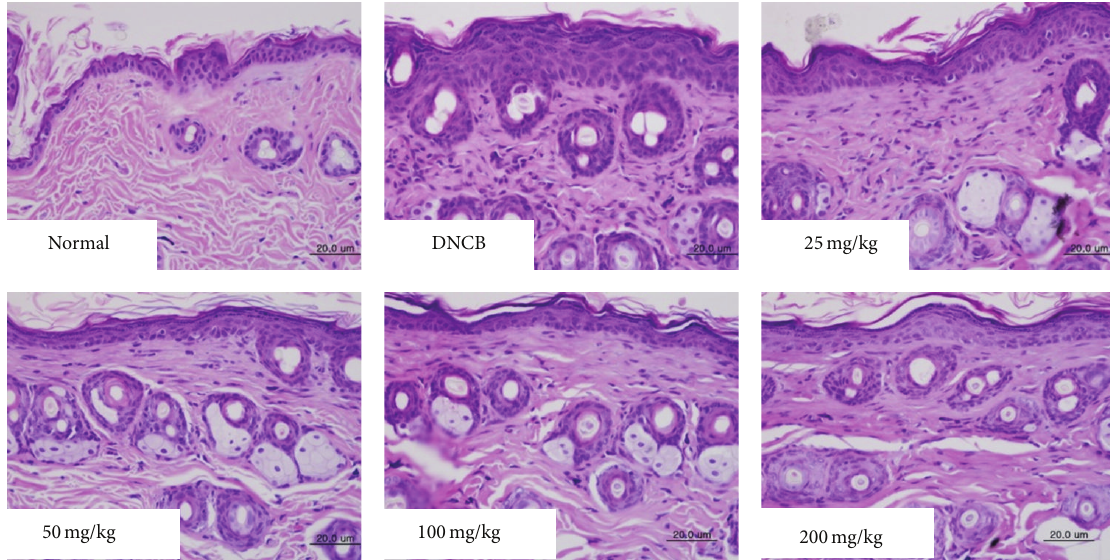
Figure 2: Histological features of AD-like skin lesions treated with CP001. The skin sections were stained with hematoxylin and eosin. Inflammatory cells infiltration into the dermis was measured after treatment with CP001 in the presence of DNCB. Sections were evaluated using microscope at an original magnification of